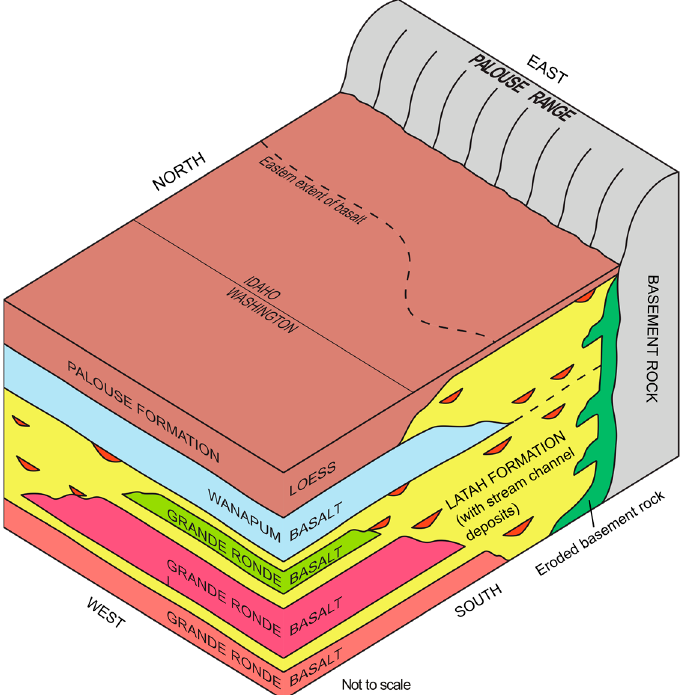
Figure 3. Theorized mountain–front interface of the Palouse Range and sedimentary units of the Latah Formation that contain paleochannel deposits from prior iterations of the stream network draining the Palouse Range (updated from Bush et al. [29]).